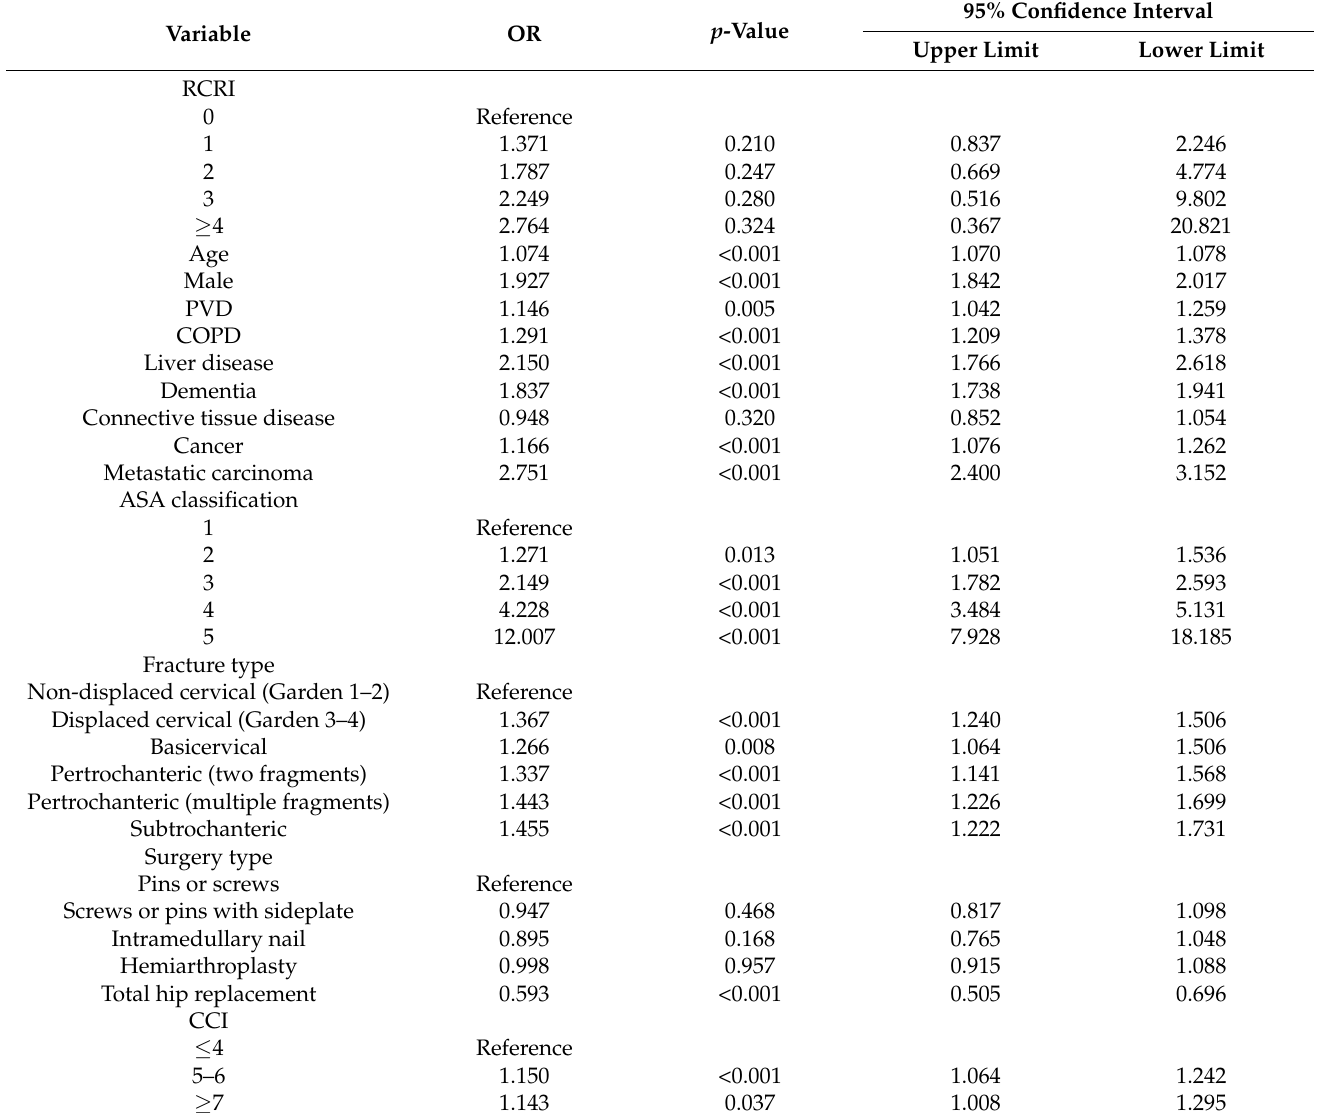
Table 2. Odds ratio (OR) of predictor variables for 30-day mortality after surgery (full LR